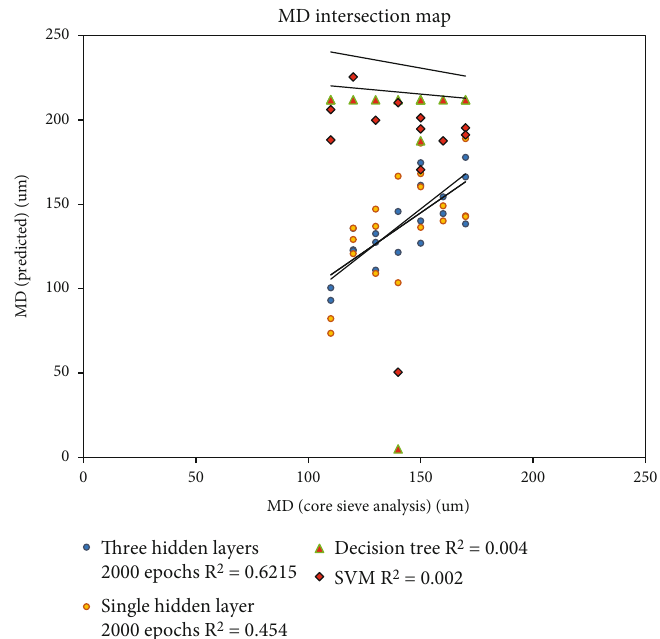
Figure 18: Intersection diagram of the median value of the predicted rock particle size and the core sieve analysis size in the S well